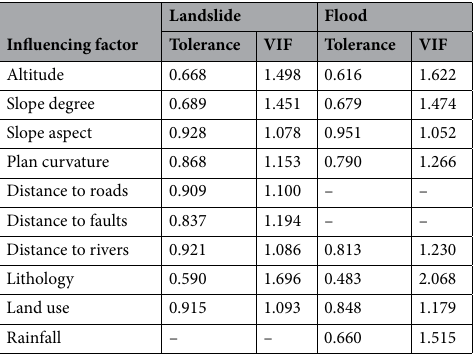
Table 1. Multicollinearity analysis.